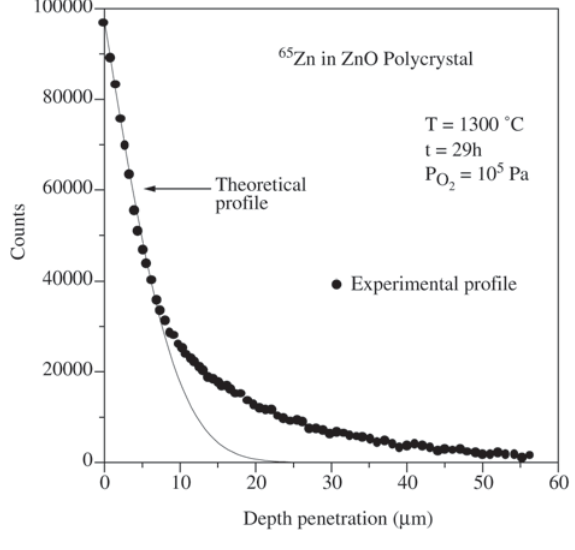
Figure 3. Comparison of volume diffusion coefficients obtained in this work with those available in the